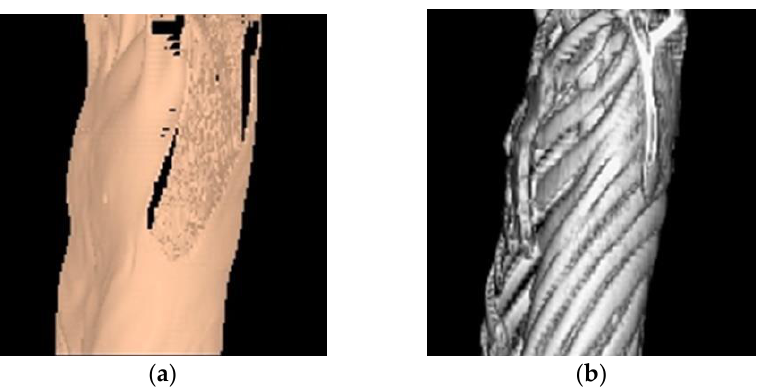
Figure 1. 3D-CT of a patient with pleuroparenchymal fibroelastosis. ( a ) 3D-CT with body surface. Flattening of the chest wall is shown. ( b ) 3D-CT with bone reconstruction. The intercostal spaces are narrow, and the anteroposterior diameter is shortened. Abbreviation: 3D-CT—three-dimensional computed tomography.